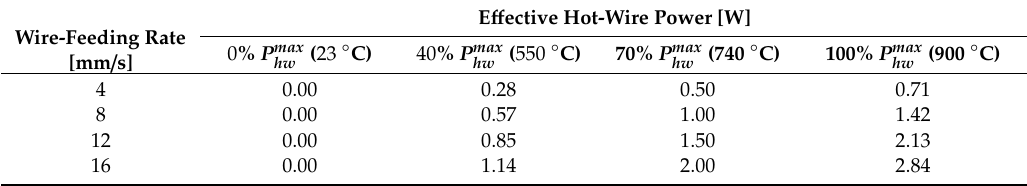
Table 3. E ff ective hot-wire powers for the applied wire-feeding rates and hot-wire powers. Wire-Feeding Rate [mm /